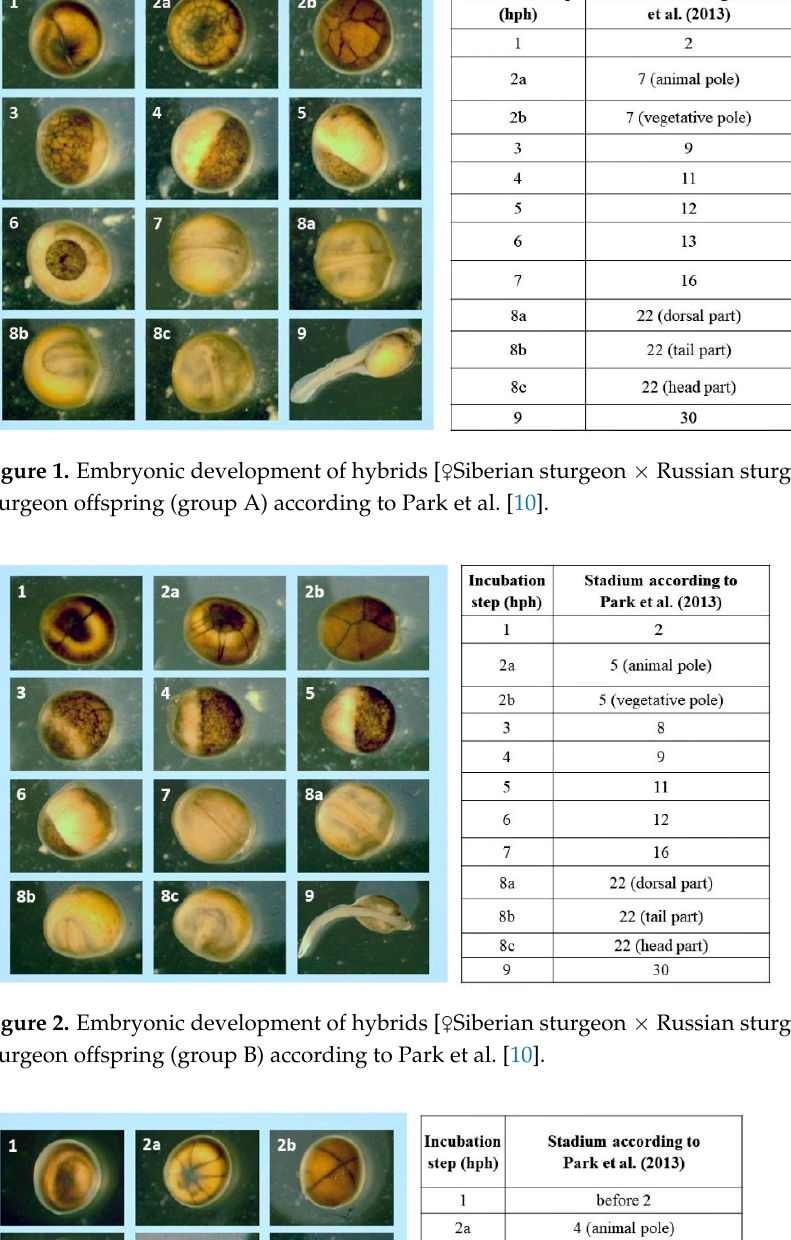
Siberian sturgeon × Siberian) offspring ♀ ♂